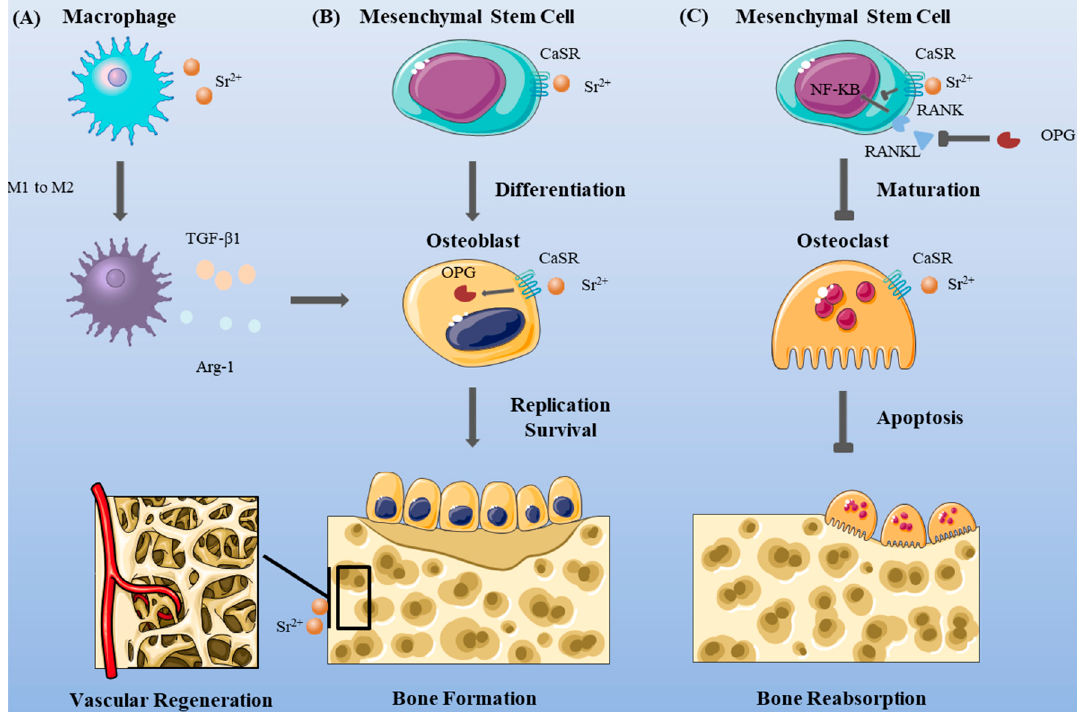
Figure 1. Mechanisms of Sr on bone regeneration: ( A ) Sr induces macrophages to differentiate toward M2 instead of M1, which benefits the promotion of osteoblast proliferation, and Sr also raises early vascular regeneration. ( B ) Sr promotes mesenchymal stem cell differentiation and osteoblast proliferation, which benefits bone formation. ( C ) Sr inhibits mesenchymal stem cell differentiation and osteoclast proliferation, which reduces bone reabsorption.